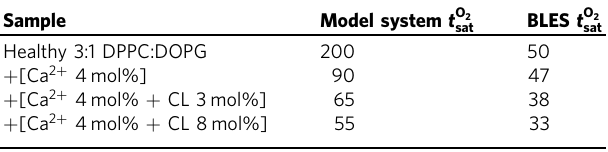
Table 1 Oxygen gas saturation times ( t O 2 pulmonary